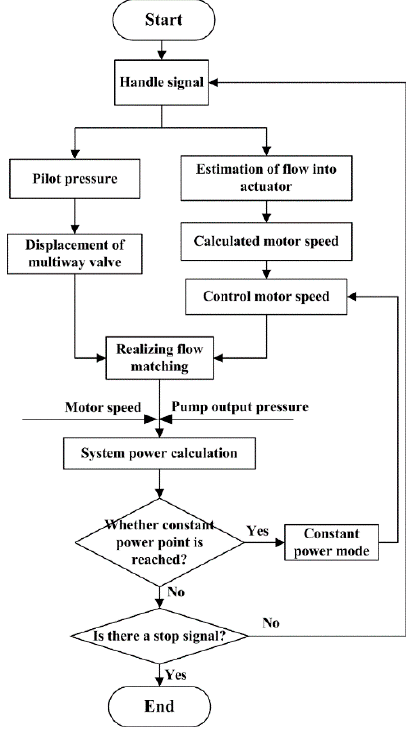
Figure 3. Flow chart of positive flow control strategy based on variable speed control.